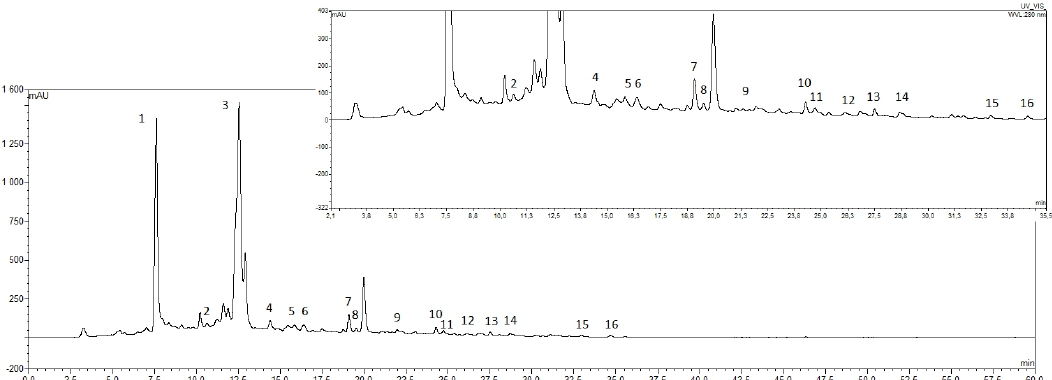
Figure 1. High performance liquid chromatography (HPLC) chromatograms of phenolic compounds in methanolic extracts of Polish yellow sweet clover honeys. Identified compounds are: (1) gallic acid; (2) 3,4-dihydroxybenzoic acid; (3) (+)-catechin; (4) 4-hydroxybenzoic acid; (5) caffeic acid;